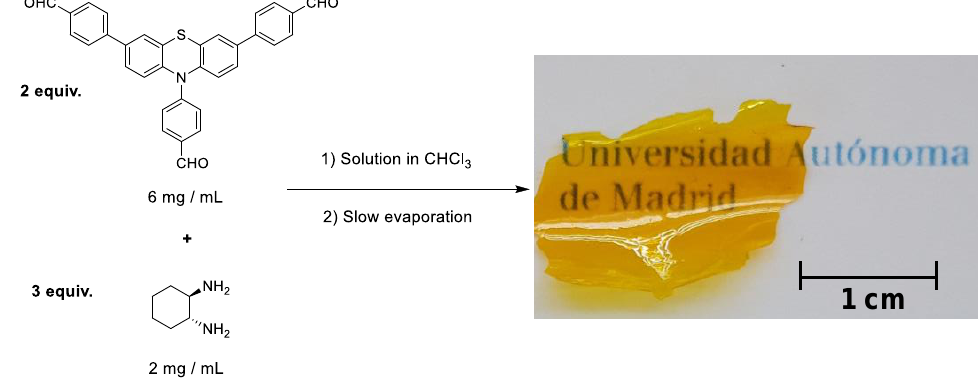
Figure 1. Synthesis of PTH-polymer.